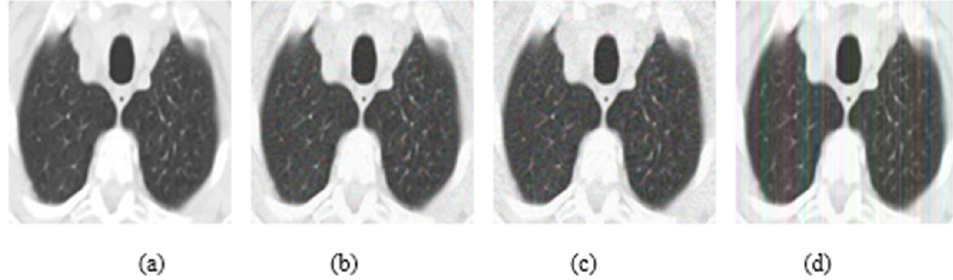
Figure 7. ( a ) Initial Image, ( b ) FGSM attack with ϵ = 0.07, ( c ) PGD attack with ϵ = 0.07, ( d ) Square Attack with ϵ = 0.07 .